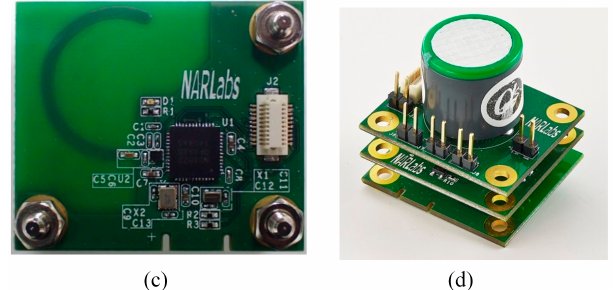
Figure 3. Photographs of the printed circuit board of ( a ) the power module; ( b ) the sensor module; ( c ) the microcontroller module; and ( d ) the complete assembled stack.